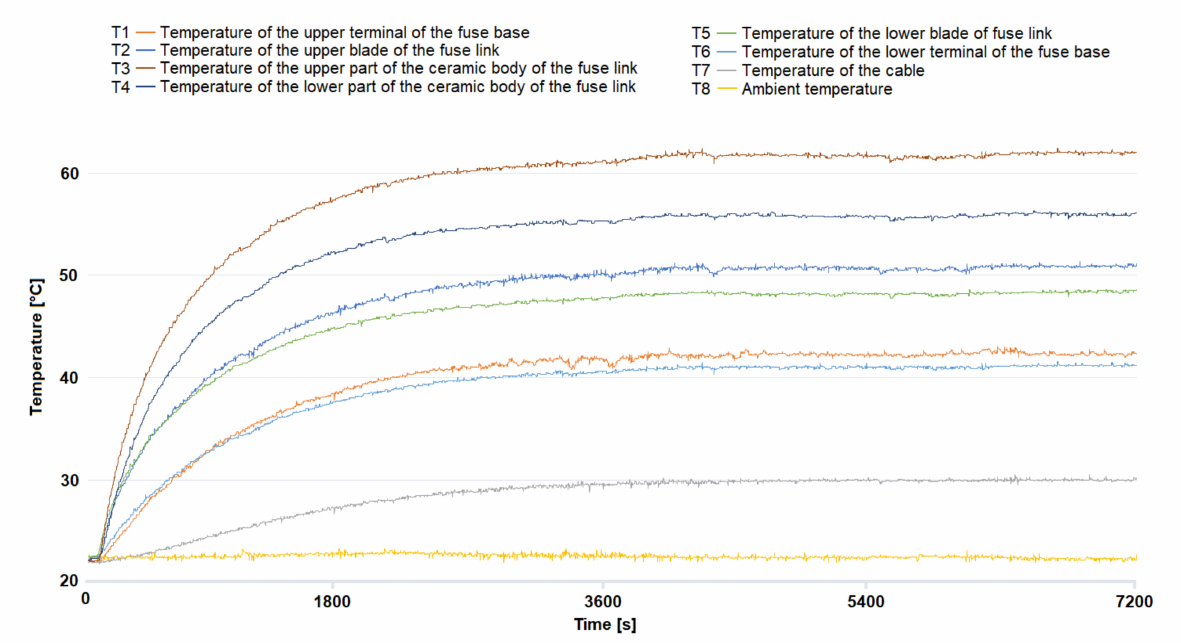
Figure 5. Chart showing results for thermocouples T1; T2; T3; T4; T5 and T6. The results were obtained for a time of 7200 s for a type of fuse NH000 gG 100 A and for a current of 110